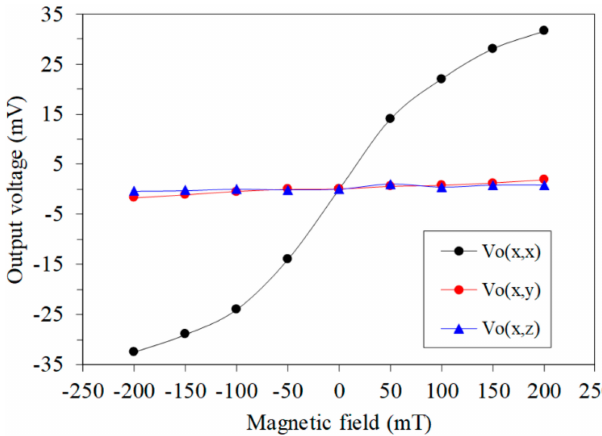
Figure 11. Output of the MMS in the x -axis magnetic